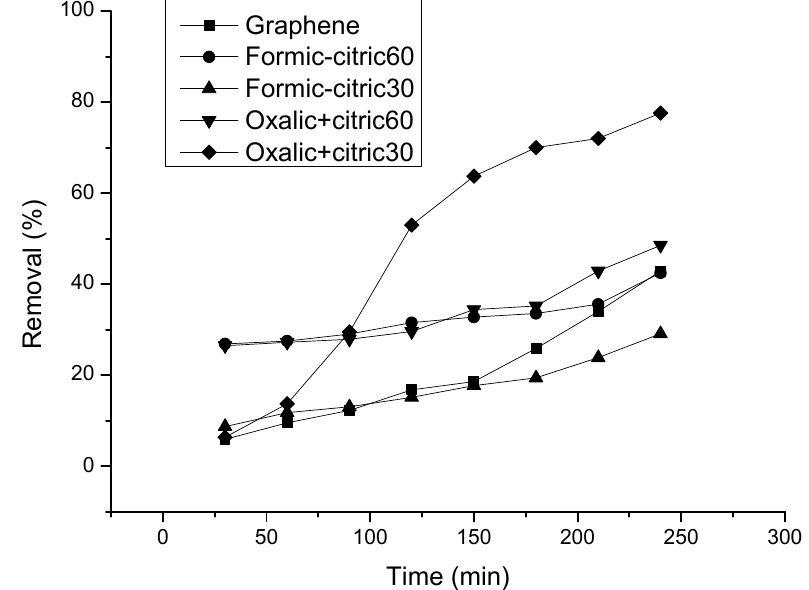
Figure 9. Percentage removal of urea using graphene and modified graphene with organic acids and ultrasonic radiation.